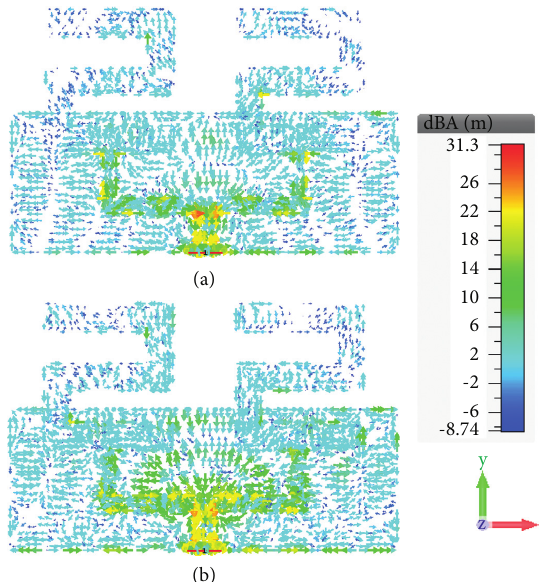
Figure 8: Proposed structure with current view distribution at the resonance frequencies: (a) 14.5GHz; (b)